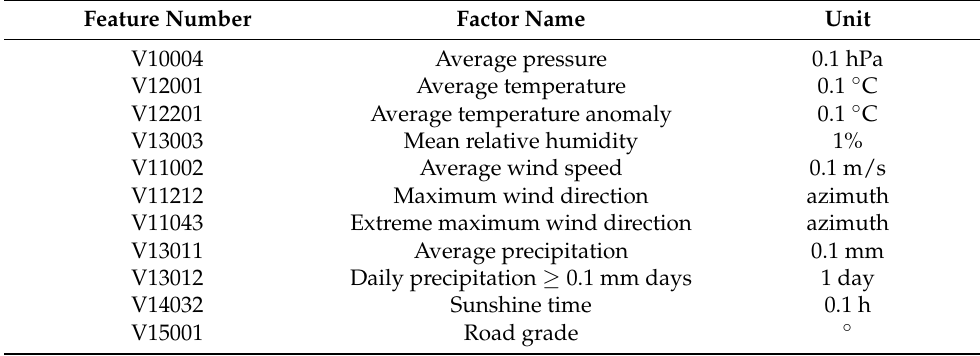
Table 5. Selected environment